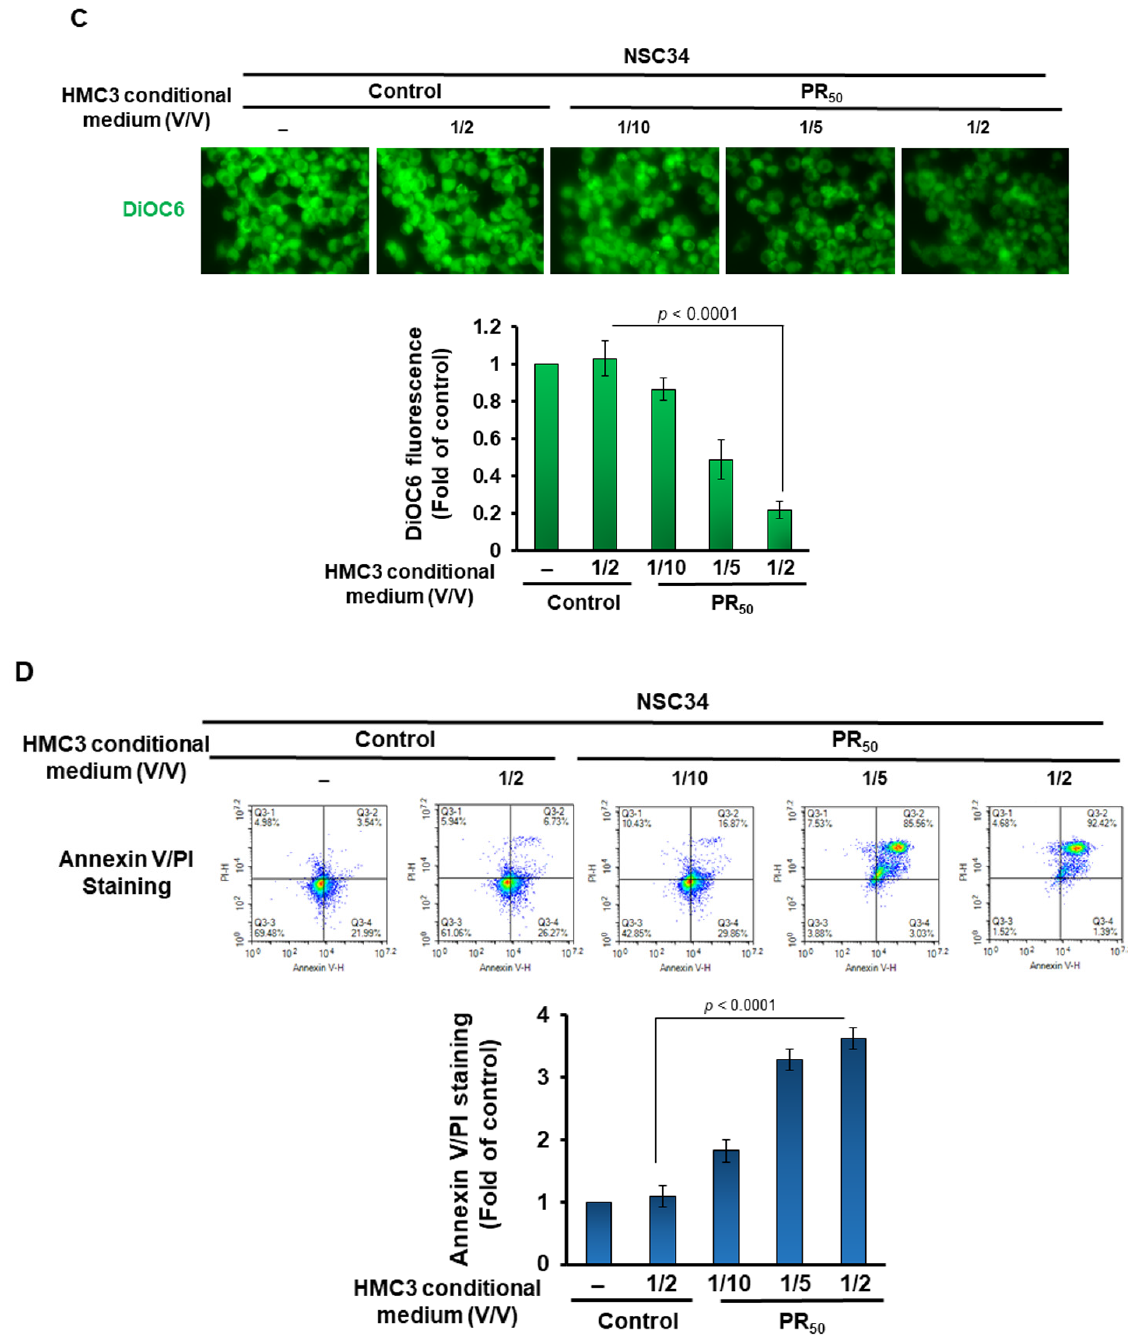
Figure 2. The conditional medium of PR 50 -expressing HMC3 cells (PR-CM) caused damage and apoptosis of mouse NSC-34 motor neuron cells. NSC-34 cells were treated with PR-CM at 1/2 ( v / v ), 1/5 ( v / v ) and 1/10 ( v / v ) volume ratios for 24 h. ( A ) Cell death was measured by lactate dehydrogenase (LDH) release via ELISA and apoptotic cells were determined by TUNEL assay. ( B ) Western blot was used to quantify the levels of apoptotic core proteins (left panel). ImageJ software was used to obtain the signal intensity of the image (right panel). The loaded internal control is GAPDH. ( C ) Mitochondrial membrane potential was determined by DiOC6 staining (green) (upper panel) and the signal intensity of the image was quantified by ImageJ software (lower panel). ( D ) Apoptotic-cell ratio was determined by annexin v-FITC and propidium iodide (PI) staining via flow cytometry (upper panel). Q2 is a late apoptotic cell, Q4 is an early apoptotic cell, Q3 is a live cell, and Q1 is a dead cell. Apoptosis ratio = (Q2 + Q4)/ (Q1 + Q2 + Q3 + Q4) × 100% (lower panel).